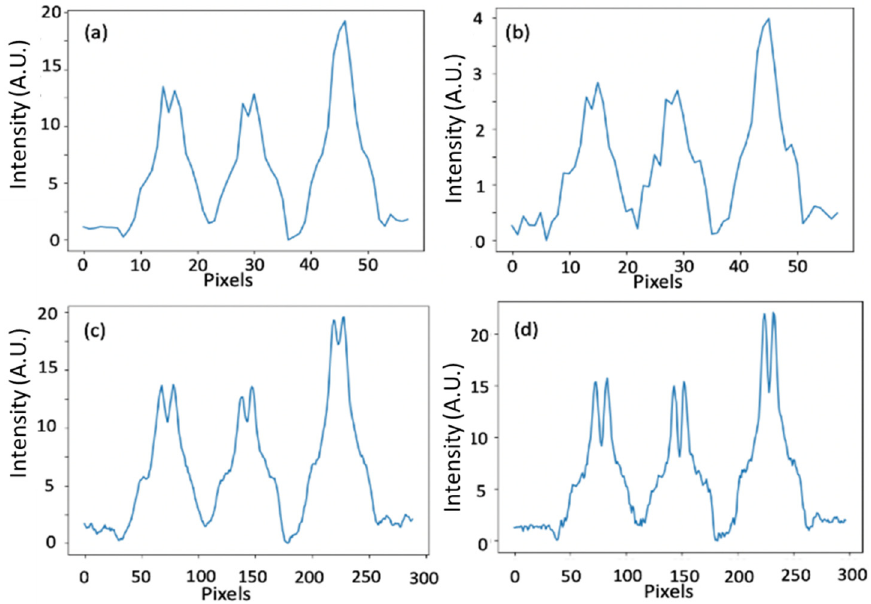
Figure 4. A single view’s projection. ( a , b ) are the low-resolution projections with an exposure time of T and T / 5, respectively, the pixel size is 0.5 mm. ( c ) The high-resolution reconstructed image. ( d ) A high-resolution reference projection was obtained with a pixel size of 0.1 mm and an exposure time of T .